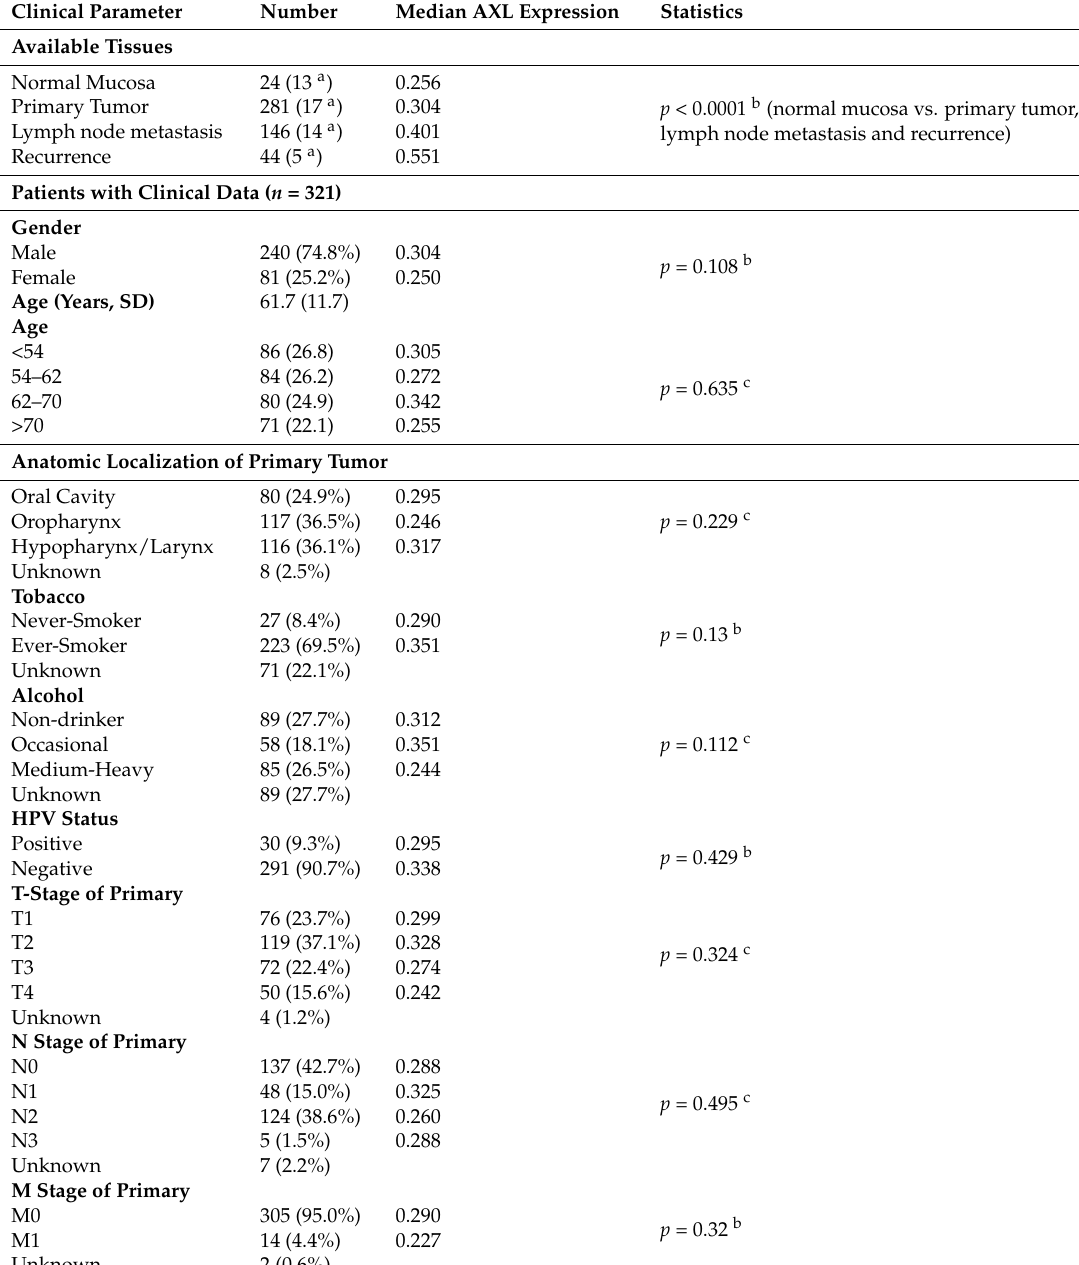
Table 1. Clinico-pathological features of the cohort used for AXL expression analyses. Bonn HNSCC Cohort ( n = 364